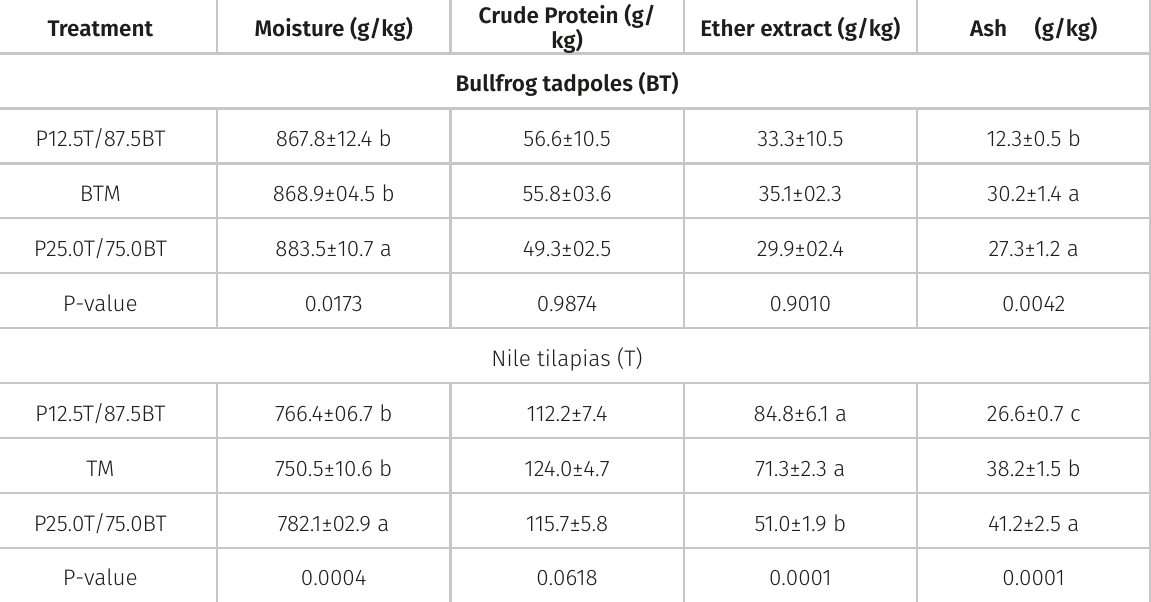
Table VII. Centesimal composition; moisture (g/kg), crude protein (g/kg), ether extract (g/kg) and ash (g/kg) of bullfrog tadpoles (BT) and Nile tilapia (T) in polyculture, tilapia monoculture (TM) and a bullfrog tadpole monoculture (BTM) experiment